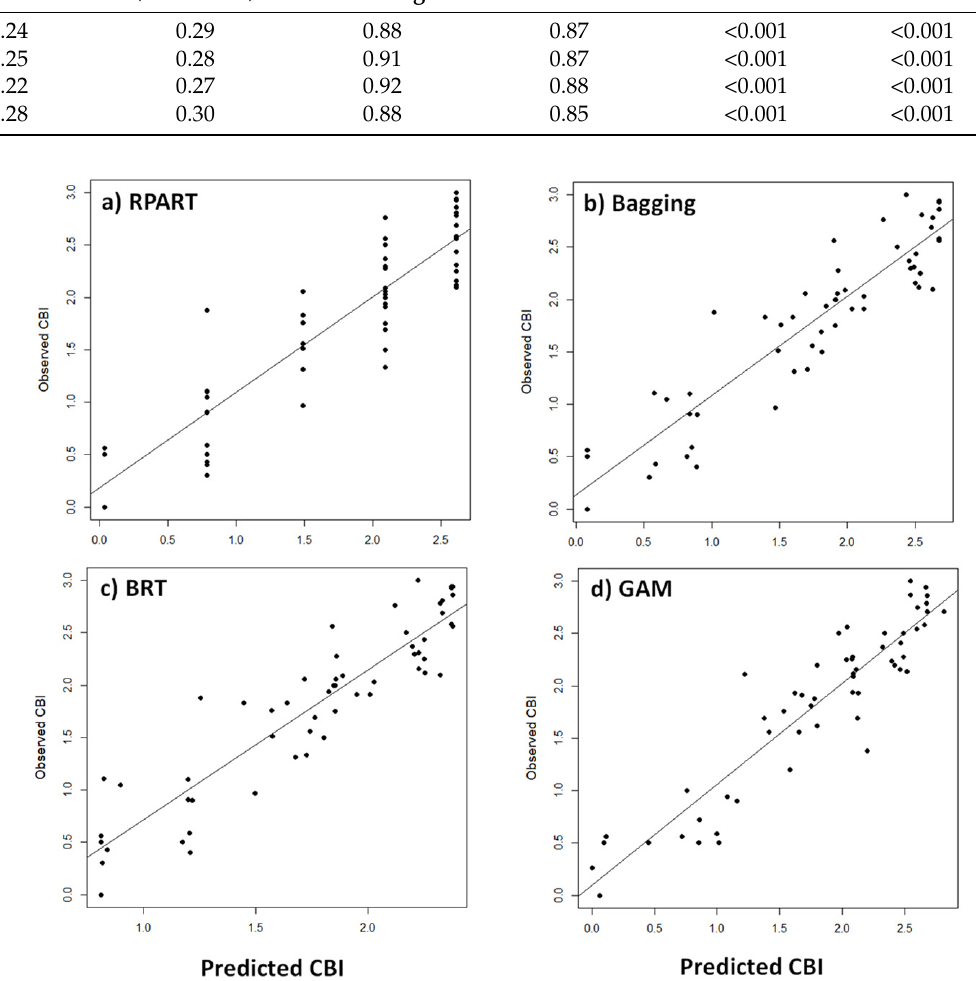
Figure 4. Scatterplots between predicted and observed CBI values merging both fires (Fernana and Takrouna) and using only test data (n = 58) from: ( a ) the regression tree (RPART); ( b ) the bagging, ( c ) the boosted regression tree (BRT), and ( d ) generalized additive (GAM) models.